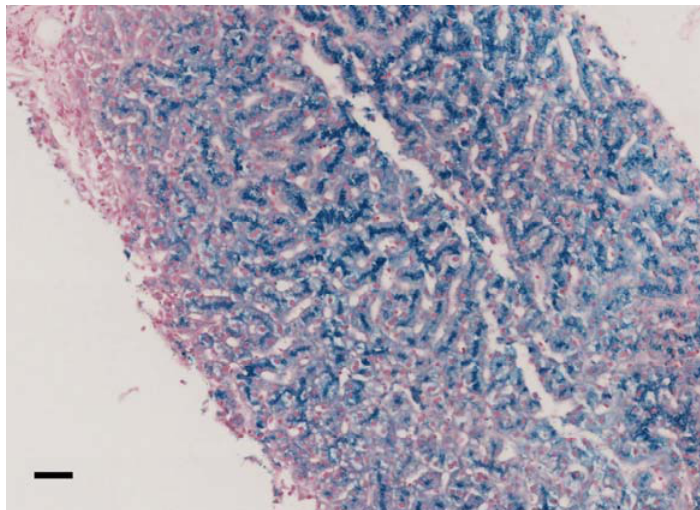
Figure 1. Liver histology of family 7 proband II.2, pearls stain (20×, scale bar = 100 μ m). Biopsy analysis showed preserved liver architecture with marked iron deposition in hepatocytes, predominating at the biliary pole of the